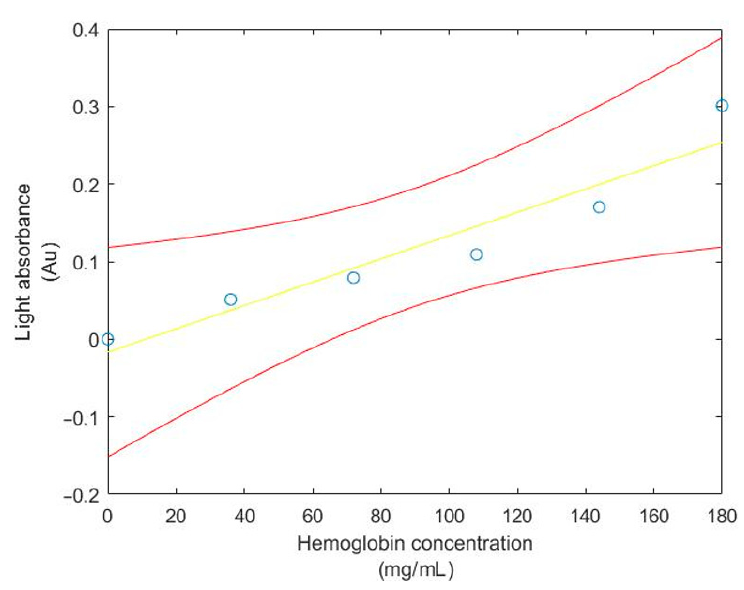
Figure 8. The 95% confidence interval of the regression line relating Hb concentration and light absorbance from the MAX30100 sensor.